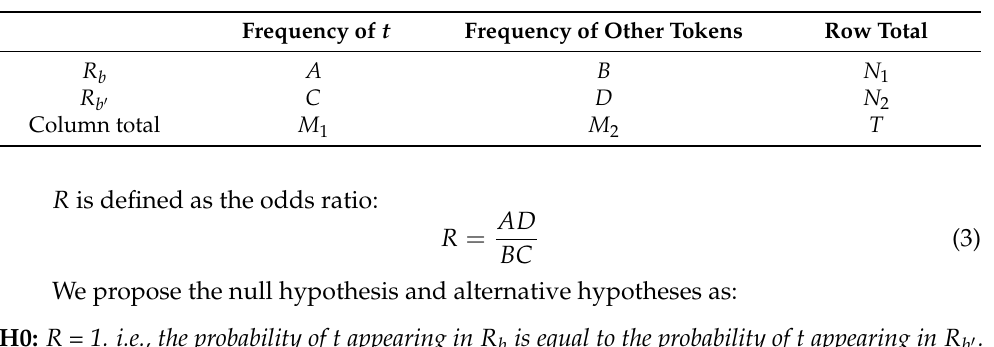
Table 1. Table for Cochran–Mantel–Haenszel